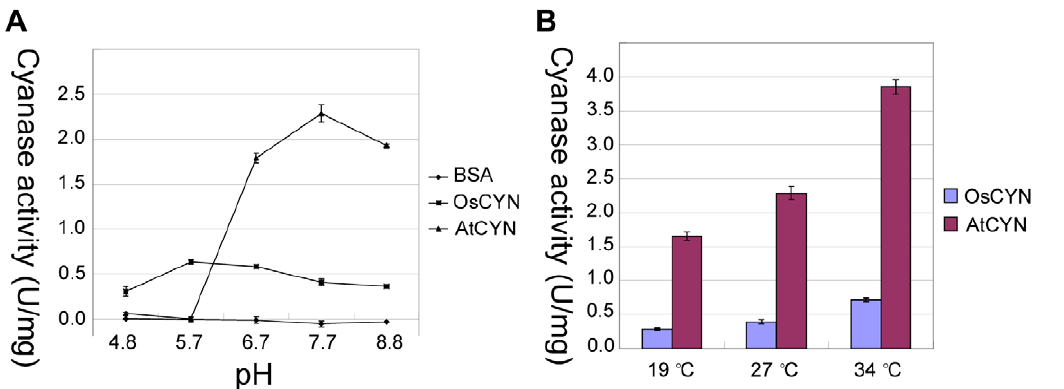
The biochemical properties of the enzymes were showed in Table 2. Activities of the cyanases of E. coli and Sordaria macrospora are affected by pH and temperature [12,21]. Therefore, activities of AtCYN and OsCYN were measured across a pH range between 4.8–8.8. As shown in Figure 3A, the optimum pH for AtCYN activity was 7.7 (2.286 U ? mg –1 ). At pH 6.7 and 8.8, AtCYN retained . 75% activity, but at a low pH (pH 5.7 and 4.8) AtCYN showed no activity. These experiments demonstrated that AtCYN